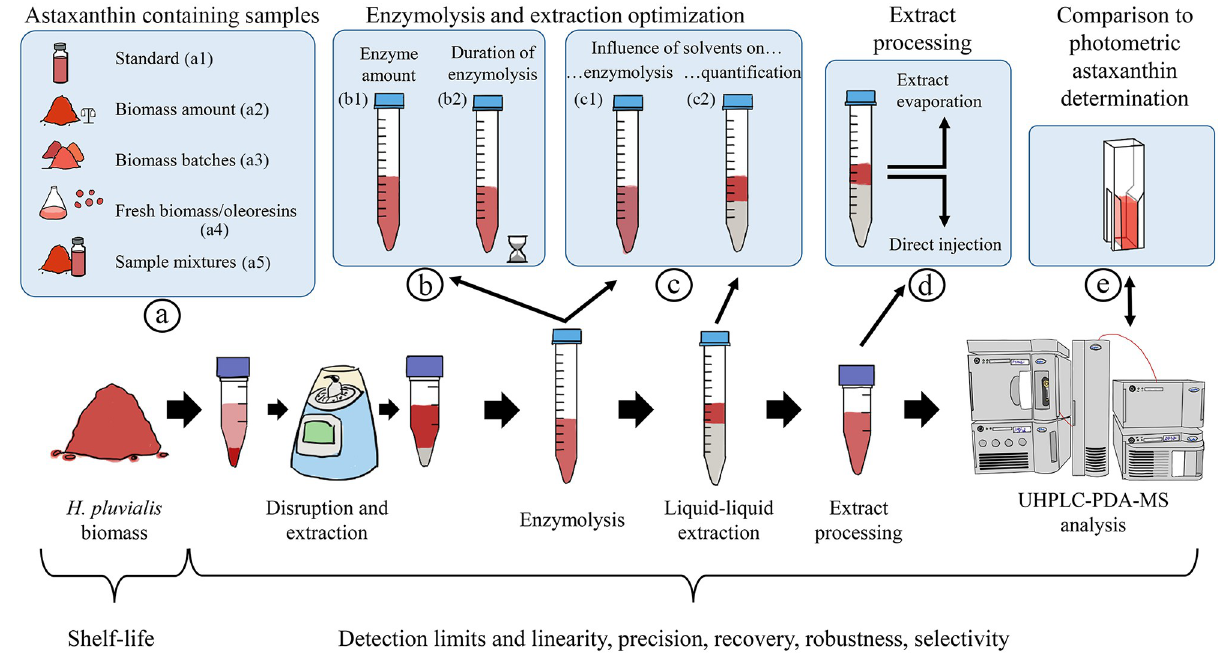
Fig 1. Schematic overview of the method development for astaxanthin